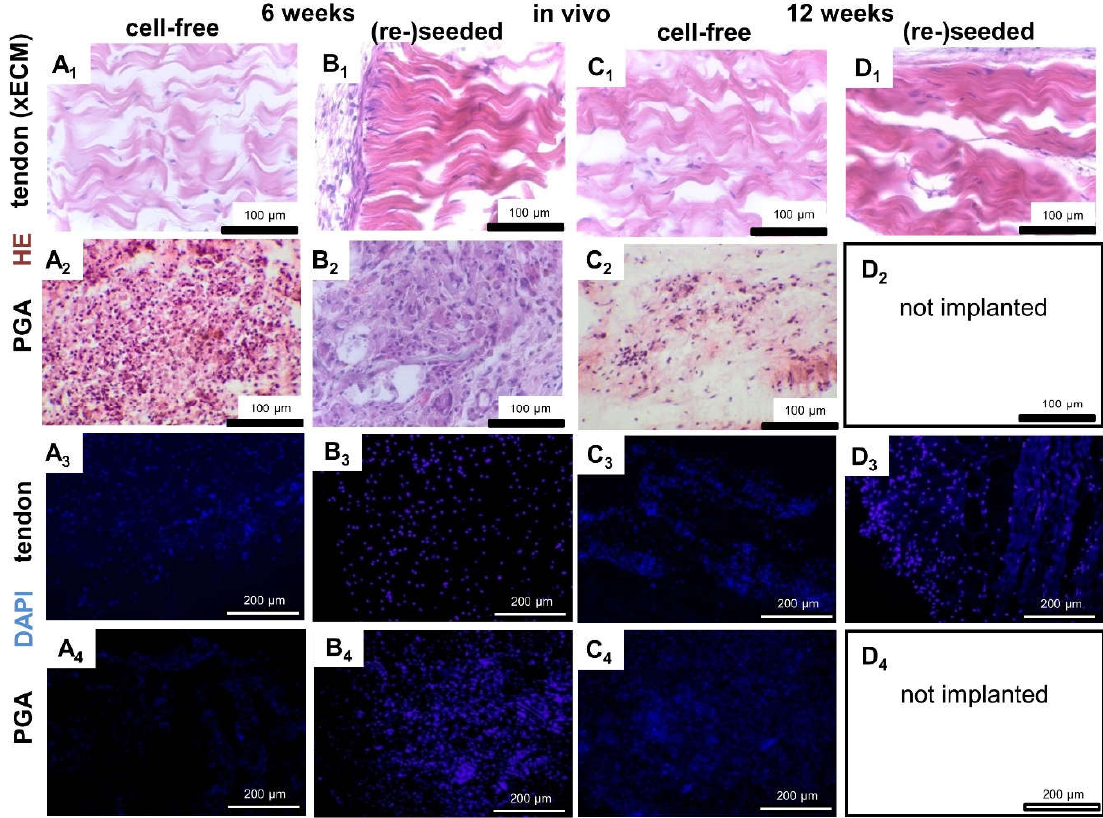
Figure 4. Histological appearance of decellularized xECM seeded or not with human tenocytes and seeded PGA and implanted for six or 12 weeks in nude mice. Histological staining of xECM ( A 1 – D 1 , A 3 – D 3 ) and PGA ( A 2 – D 2 , A 4 – D 4 ) after in vivo implantation for six weeks ( A 1 – B 4 ) and 12 weeks ( C 1 – D 4 ). ( A 1 – D 2 ) HE staining. ( A 3 – D 4 ) DAPI staining. xECM or PGA were implanted either cell-free ( A 1–4 , C 1–4 ) or reseeded with human tenocytes ( B 1–4 , D 1–4 ). Scale bars 100 µ m ( A 1 – D 2 ) and 200 µ m ( A 3 – D 4